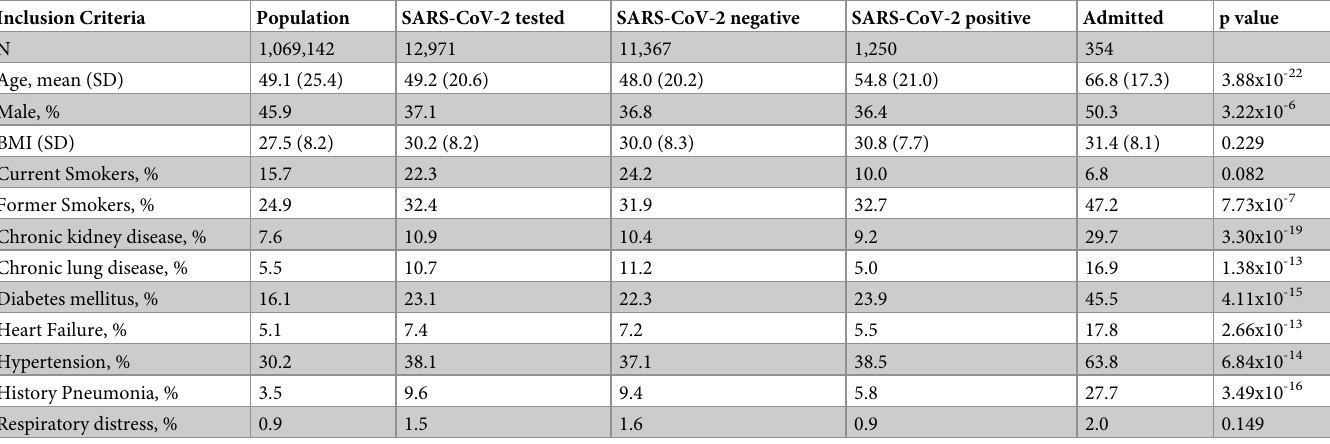
Table 1. Patient demographics and prevalence of select chronic conditions derived from EHR.